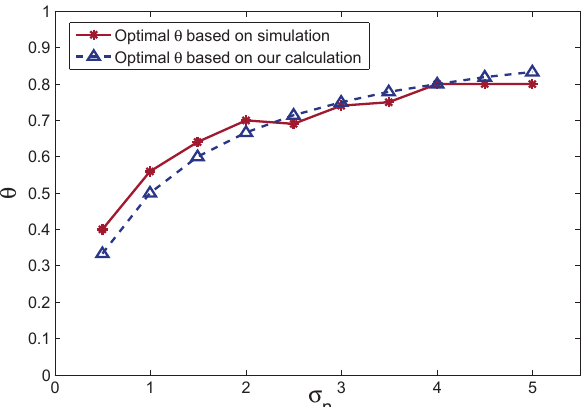
Figure 8. Optimal θ comparison between the simulation results and our calculation based on Equation (24).